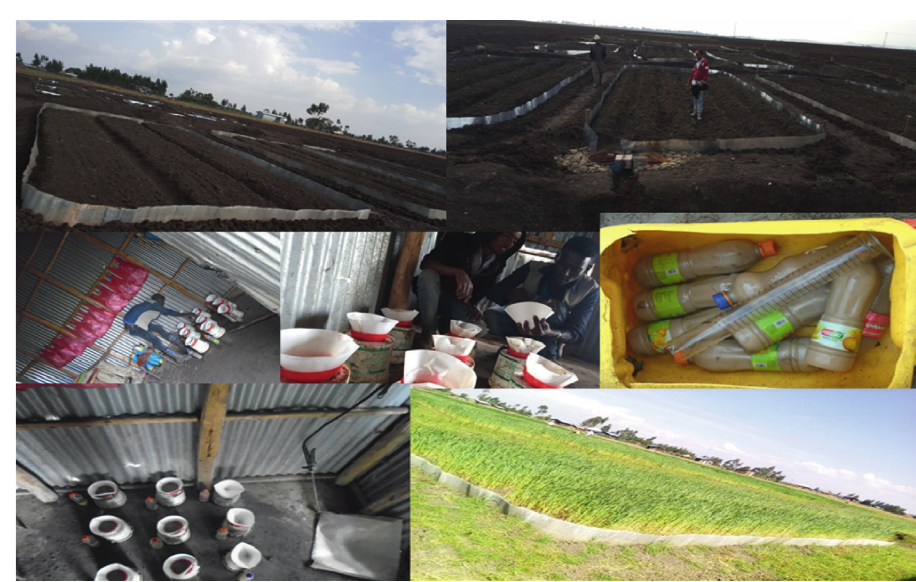
Figure 3: Land preparation, water sample collection, and sediment filtration